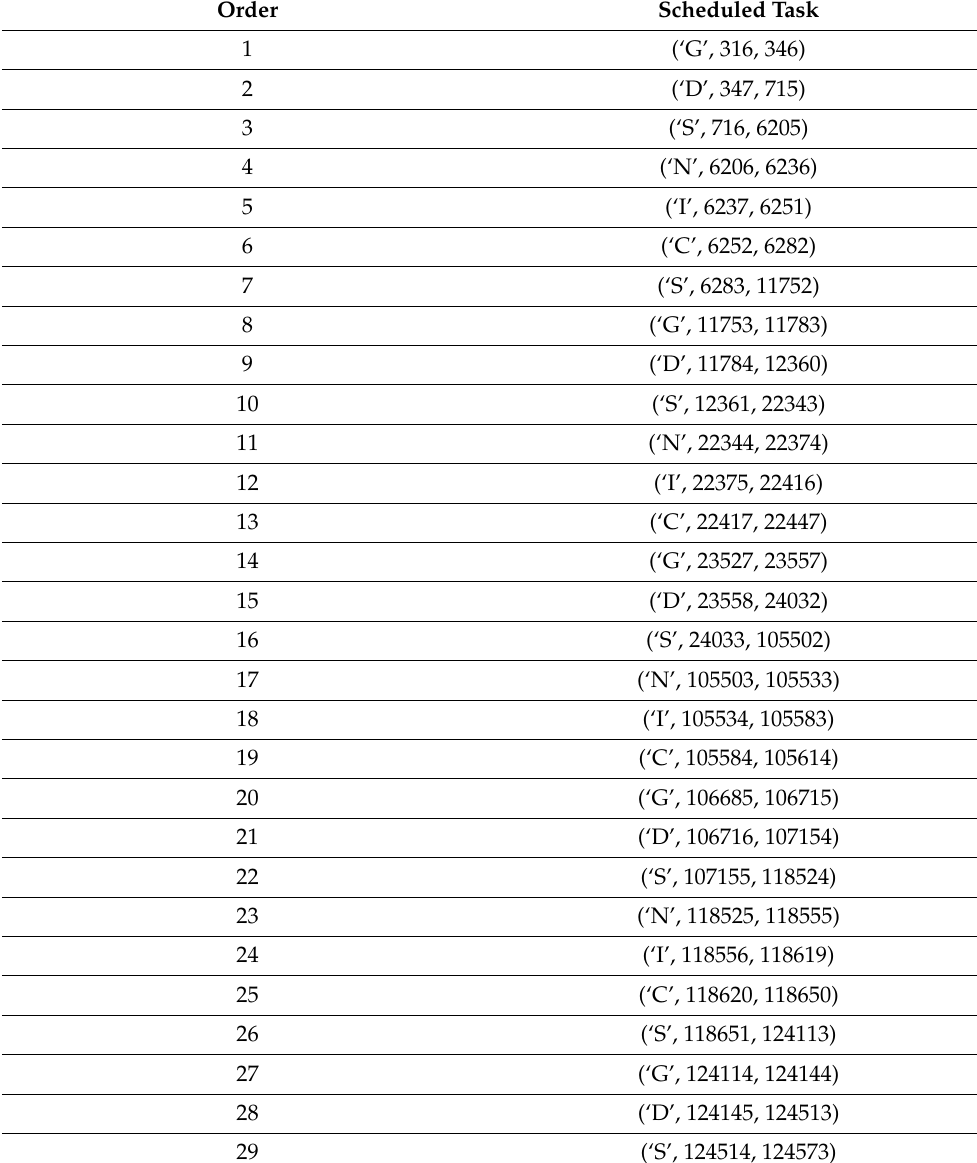
Table 7. Heuristic-Based Scheduling